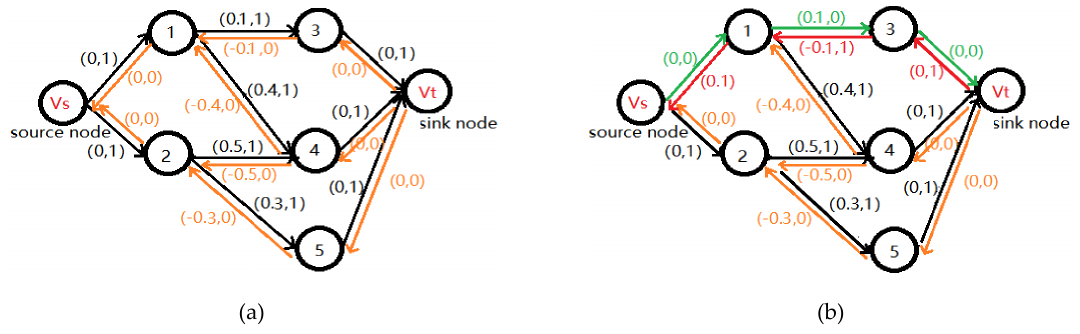
Figure 6. Minimum cost–maximum flow (MCMF)-based graph-matching. ( a ) and ( b ) are, respectively the residual digraph construction and update.